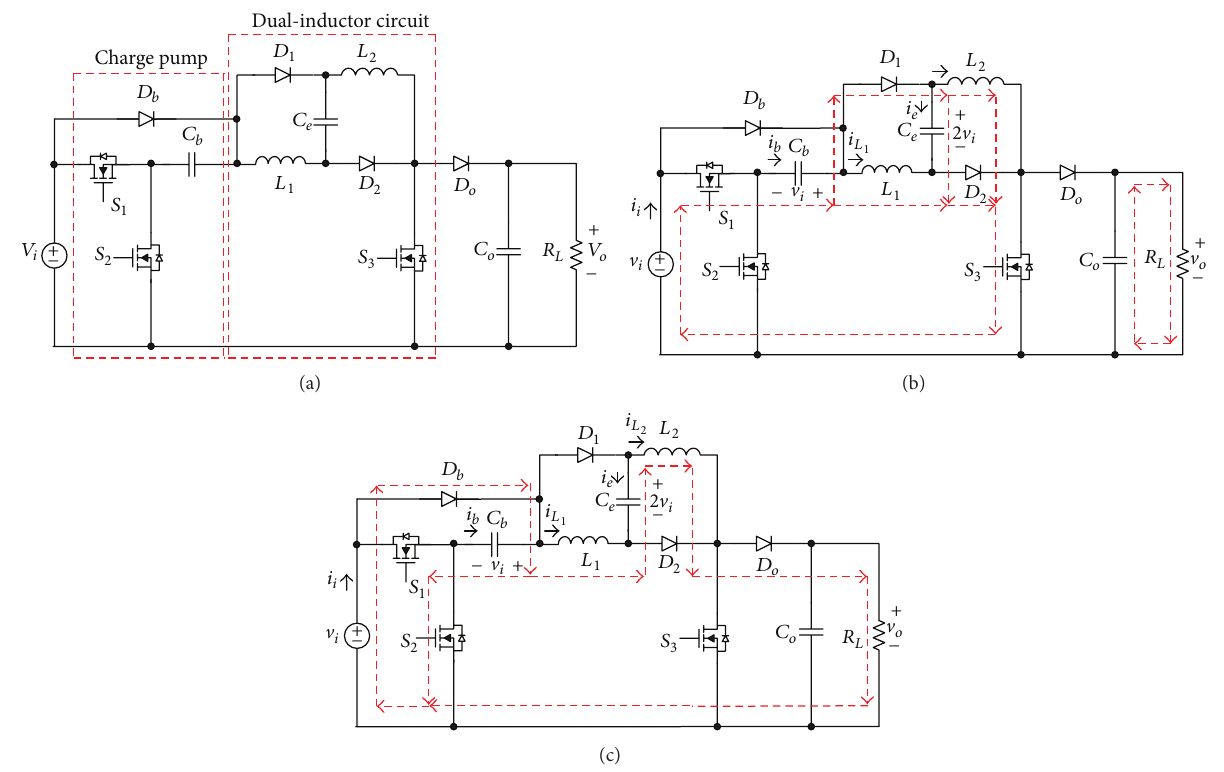
Figure 2: (a) Proposed high step-up converter; (b) current flow in State 1; (c) current flow in State 2.